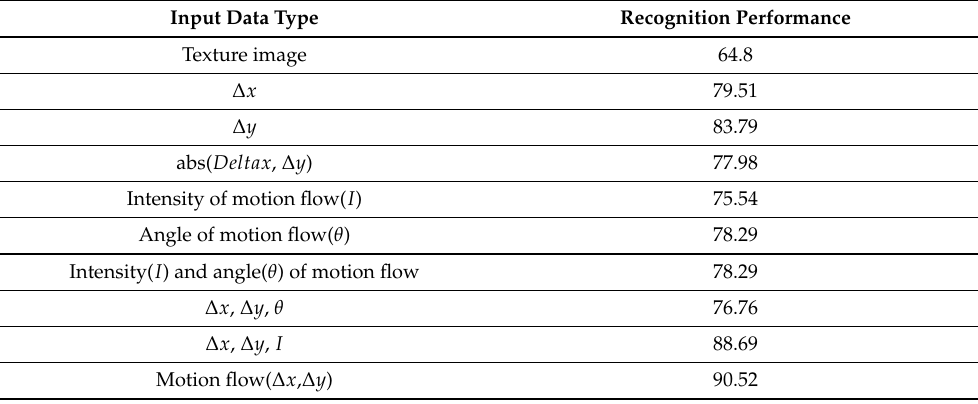
Table 4. Modified CNN-based facial expression recognition performance according to different input data